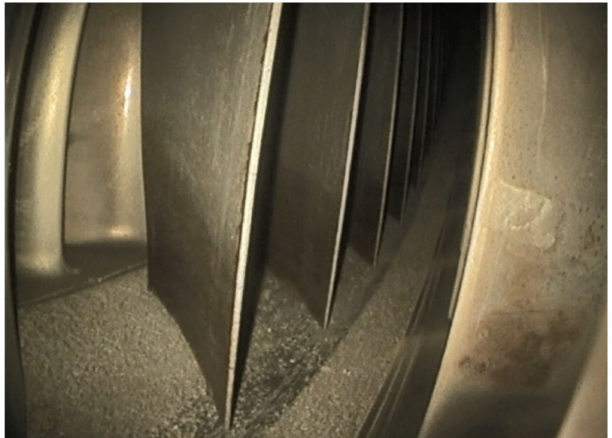
Figure 1. Typical borescope view.